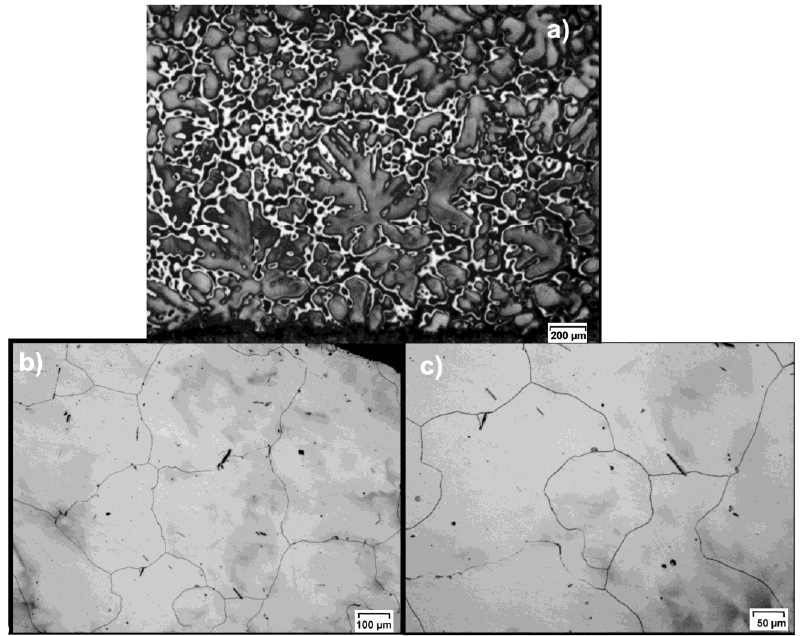
Figure 2. The structure of the AZ31 magnesium alloy used in the tests: ( a ) as-cast (provided by the manufacturer), mag. ×50, ( b ) s-homogenized, mag. ×100, ( c ) mag. ×200). Tensile tests were performed with a Zwick Z100 (ZwickRoell GmbH & Co. KG, Ulm, Germany) testing device, using standard round samples with a diameter of 5 mm for the initial material and the length of the measuring base of 100 mm. However, for as-rolled bars, no samples were taken and the tearing was performed for three ready-made bars with the diameter of 15 mm rolled according to the assumed variants, which was to de- termine the influence of the obtained bimodal structure on their properties. Furthermore, both for the feedstock and for the samples taken from rolled rods, the microhardness measurement was carried out by the Vickers method using a semi-automatic Future-Tech FM700 (FUTURE-TECH CORP., Kawasaki, Japan) microhardness tester. The microhard- ness tests were performed for samples taken from rolled bars in accordance with the as- sumed variant (a sample from each rolled bar), and for each of them, the measurement was taken on the longitudinal section, with the load of 50 g. Theoretical tests of the rolling process of AZ31 alloy bars were conducted using com- mercial software, i.e., Forge NxT 2.1 (Transvalor, Biot, France). The visco-plastic deformed metal model and three-dimensional state of strain were assumed for the numerical exam- ination: ij n ij TKS 1 )3)(,,(2 − = (2) where: S ij is the deviatoric stress tensor, is the equivalent strain rate, ε ij is the equivalent strain rate tensor, — equivalent plastic strain, T is the temperature, K — consistence being dependent on the yield stress σ p , n — factor characterizing hot metal deformation (0 < n < 1). The friction conditions on the surface of metal-rolls contact are described with the Coulomb friction model and the Tresca friction model, in which appropriate coefficient values are taken: